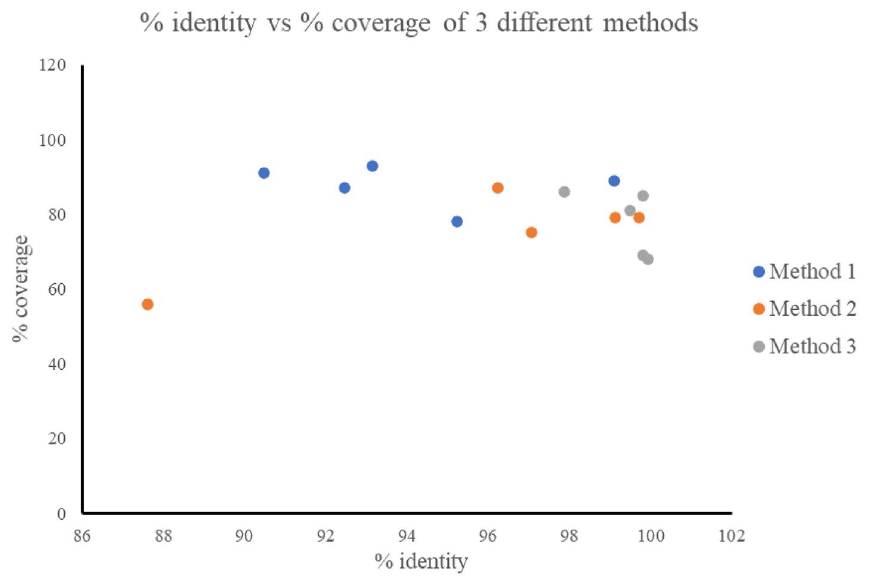
Figure 4. Consensus sequence comparison of three different analyses methods (Method 1- CAP3 de novo assembly. Method 2- Geneious de novo assembly, Method 3- Geneious reference mapping) against